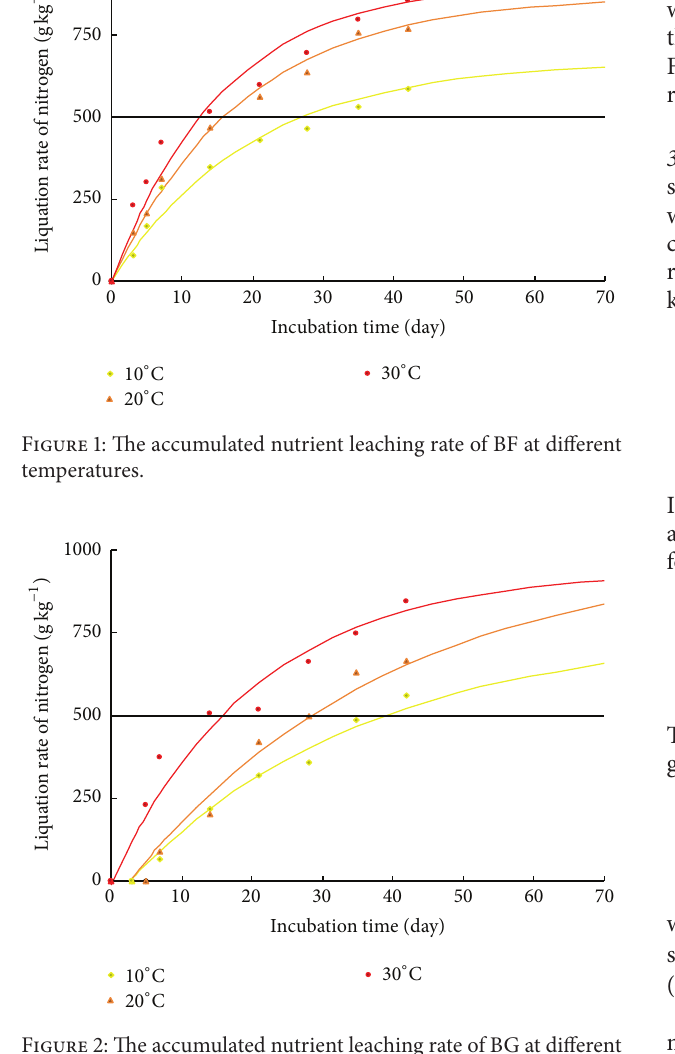
Figure 2: The accumulated nutrient leaching rate of BG at different